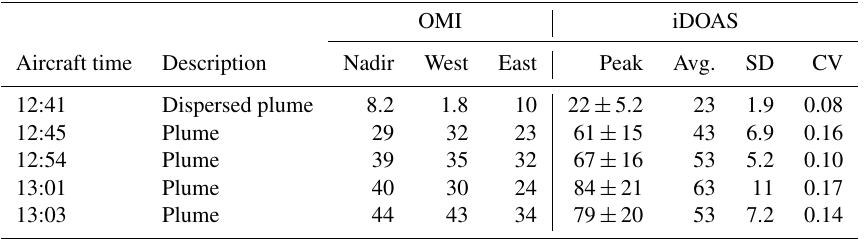
Figure 14. A comparison of the airborne DOAS 10s moving average NO 2 vertical column densities with DOMINO V2.0 on 18 August 2007. Data presentation is as in Fig. 9. Table 4. Cases of background and plume measurements identified from the iDOAS measurements on 18 August 2007. Aircraft time is given in UTC. OMI nadir refers to the TVCD value in the OMI pixel at aircraft nadir. Similarly, OMI east and OMI west refer to the OMI pixel one row east and west of aircraft nadir respectively. iDOAS peak refers to the peak VCD within the OMI pixel at aircraft nadir. iDOAS average is the line-averaged iDOAS measurements within the OMI pixel at aircraft nadir, and iDOAS standard deviation is the iDOAS-measured variability within this OMI pixel expressed as a standard deviation. iDOAS CV is the coefficient of variation (or relative standard deviation) of the measured variability. All column densities are expressed in petamoleccm − 2